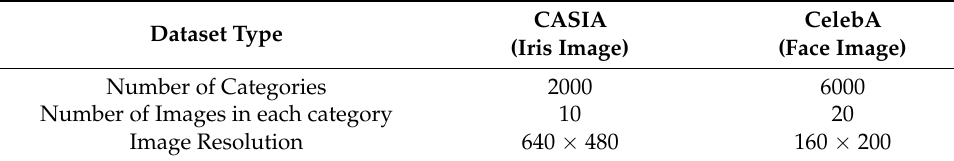
Table 1. Biometric dataset